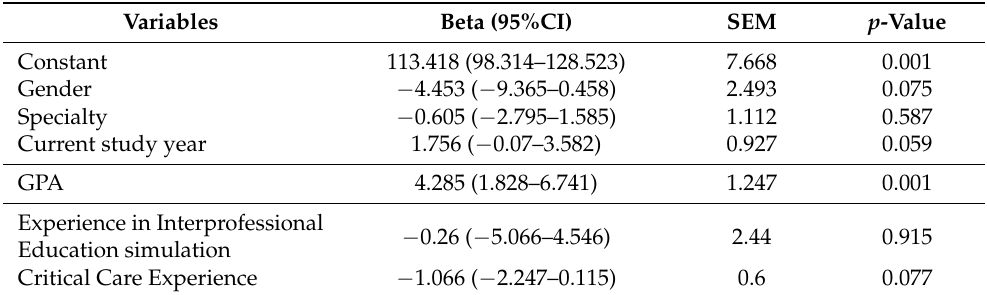
Table 4. Predictors of positive students’ attitudes and perception toward